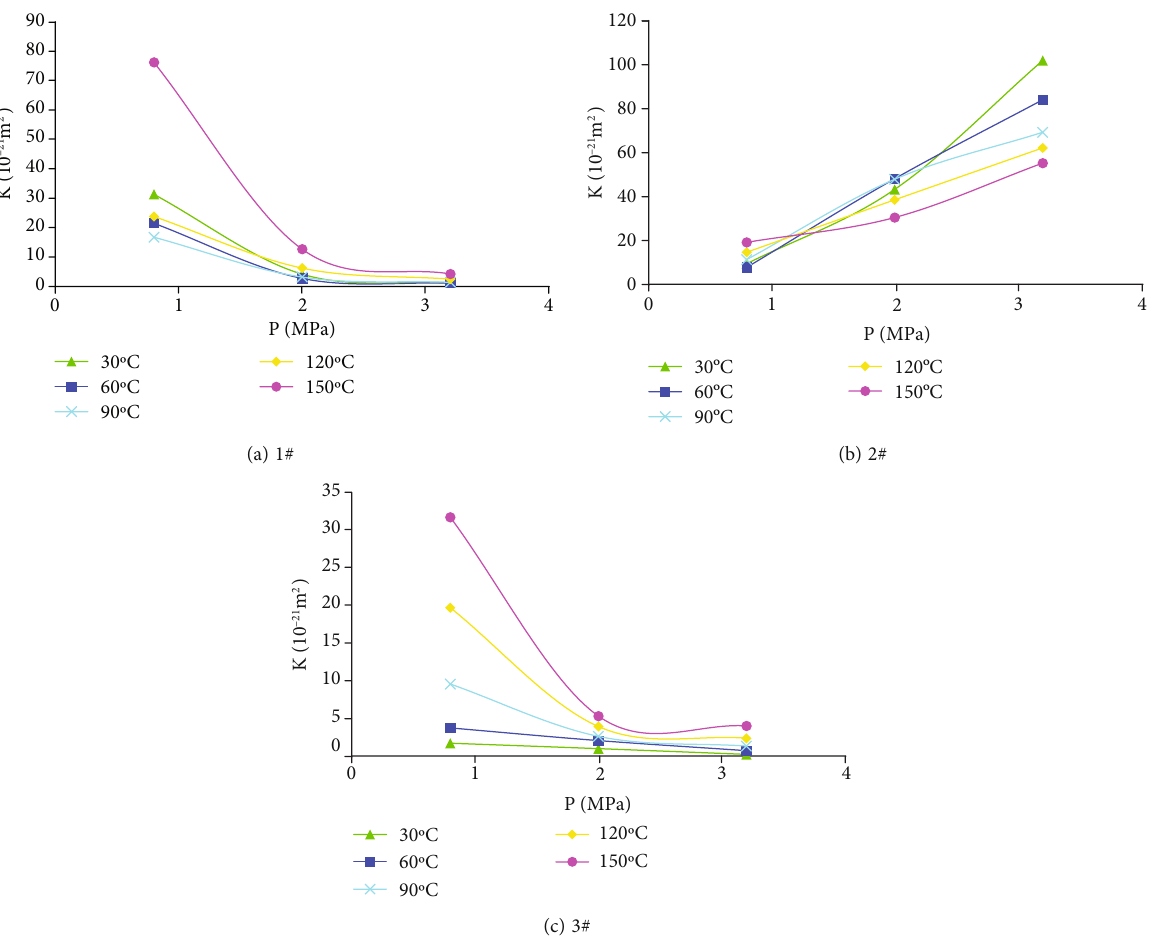
Figure 7: Relationship curve between coal permeability and pore